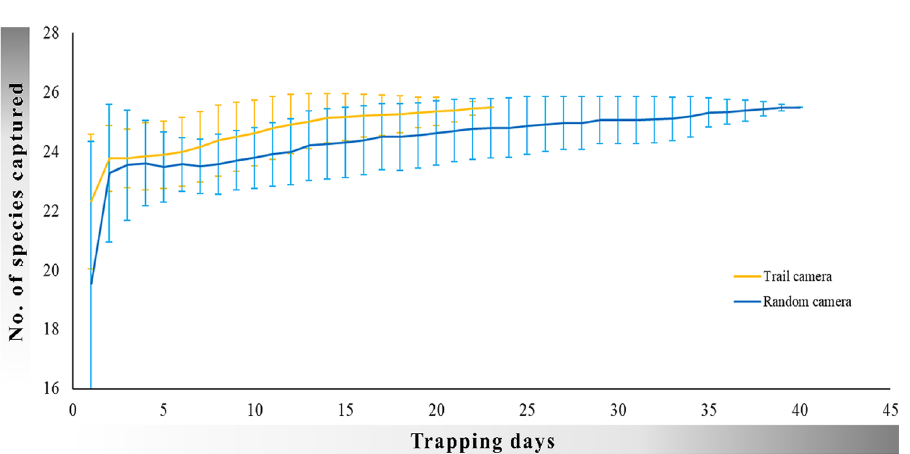
Figure 2. Species accumulation curves from trail (yellow line) and random (blue line) camera setups describing the rate at which species were captured in two setups. The vertical bars represent 95% confidence